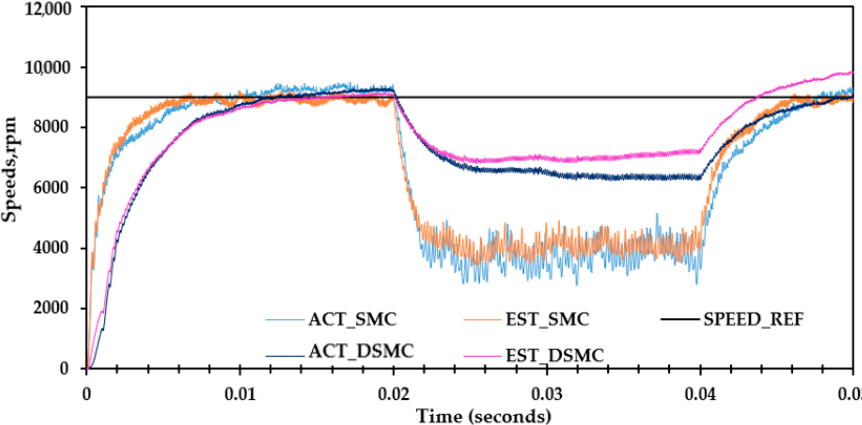
Figure 25. Changes in the load torque. [Note: ACT_SMC: actual speed under sliding mode controller; EST_SMC: estimated speed under sliding mode controller; ACT_DSMC: actual speed under dynamic sliding mode controller; EST_DSMC: estimated speed under dynamic sliding mode controller; SPEED_REF: reference speed]